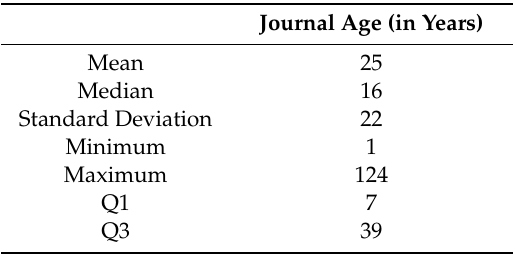
Table 3. Summary statistics for journal age at the time of the reverse flip.